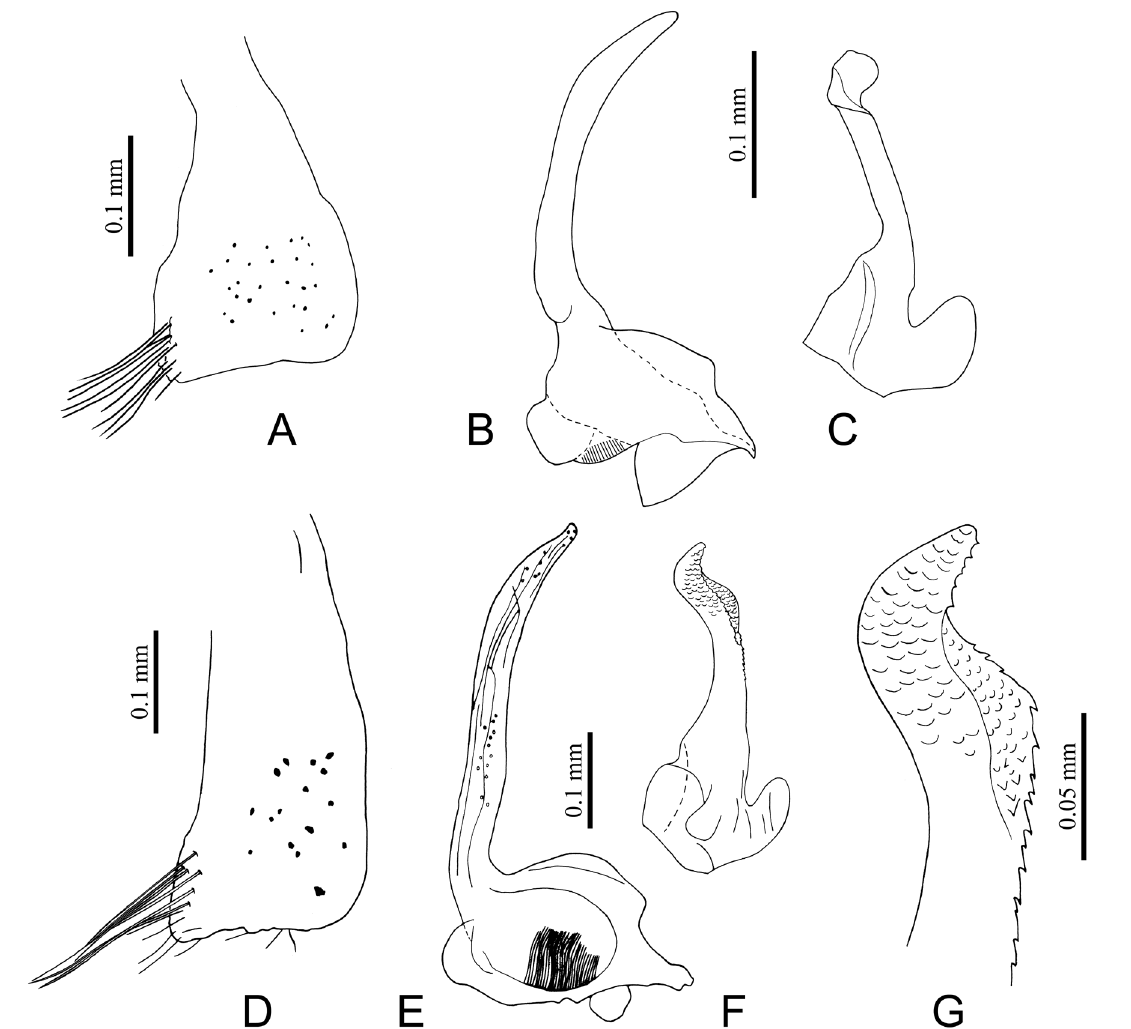
Fig. 4. Morphological features of species of Micronecta Kirkaldy, 1897, ♂♂. A–C . M . ludibunda Breddin, 1905 (ZVNU). D–G . M . sahlbergi (Jakovlev, 1881) (ZVNU). A, D = free lobe; B, E = right paramere; C, F = left paramere; G = apical part of left